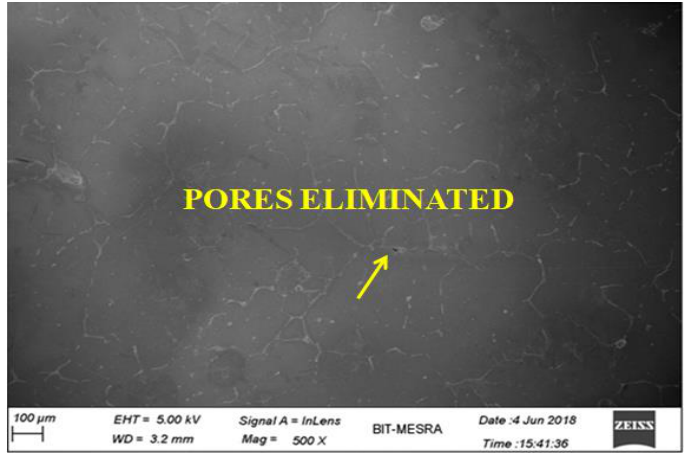
Figure 7. SEM image of sample cast by counter gravity process with 8 mm sprue